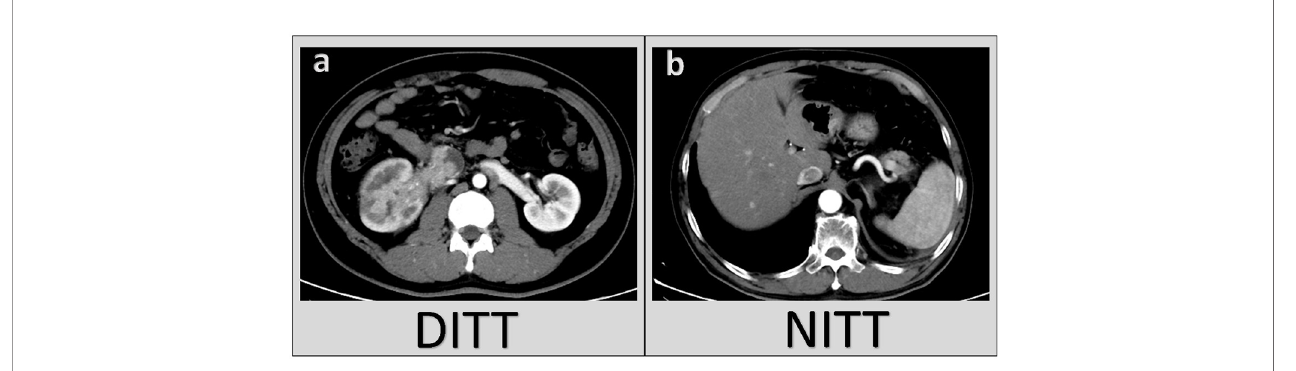
FIGURE 1 | Typical CT image appearances in the Deep Invasive Tumor Thrombus (DITT) group (A) and the Non-Invasive Tumor Thrombus (NITT) group